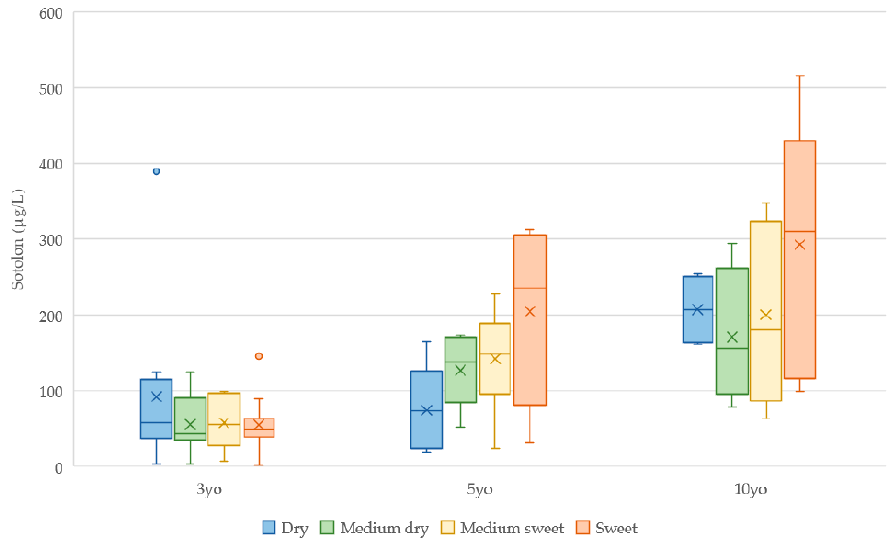
Figure 1. Box plot of sotolon contents (in µg/L) in 3-, 5- and 10-year-old MW blends.